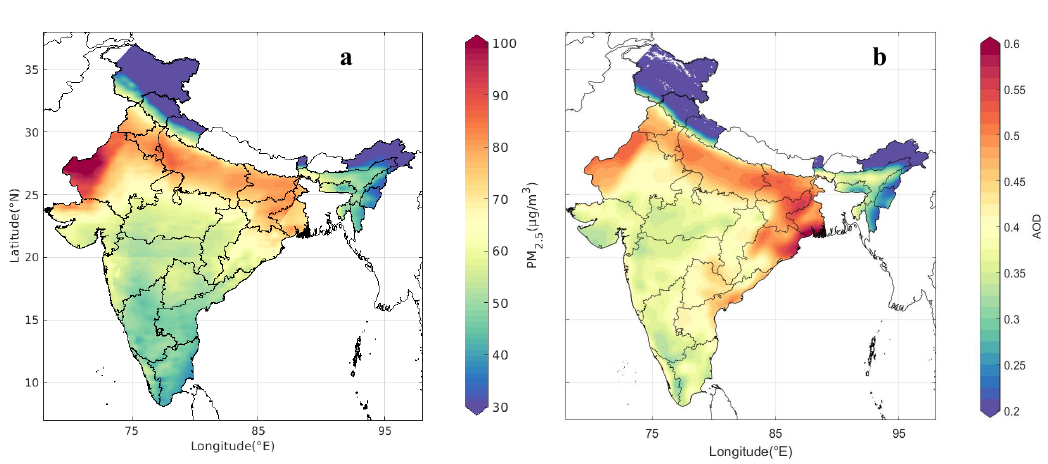
Figure 5. The spatial patterns of ( a ) annual PM 2.5 and ( b ) annual aerosol optical depth (AOD) averaged for the 20-year (2000–2019) period over India.